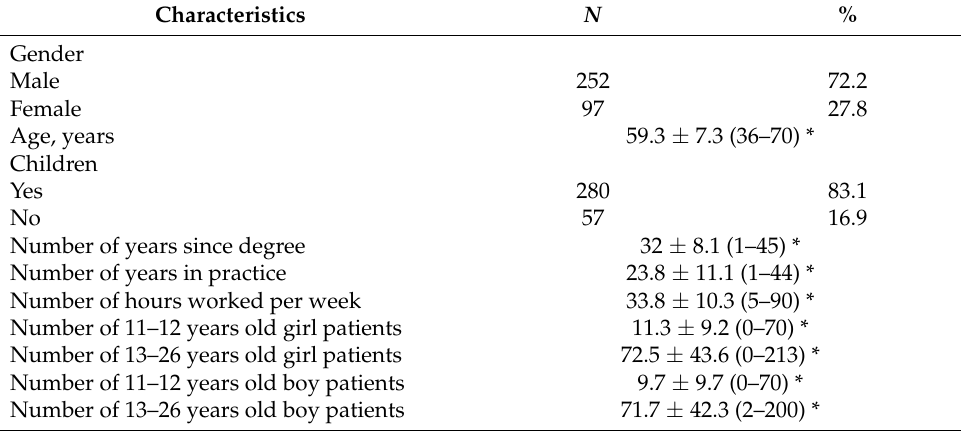
Table 1. Socio-demographic and professional characteristics of the study